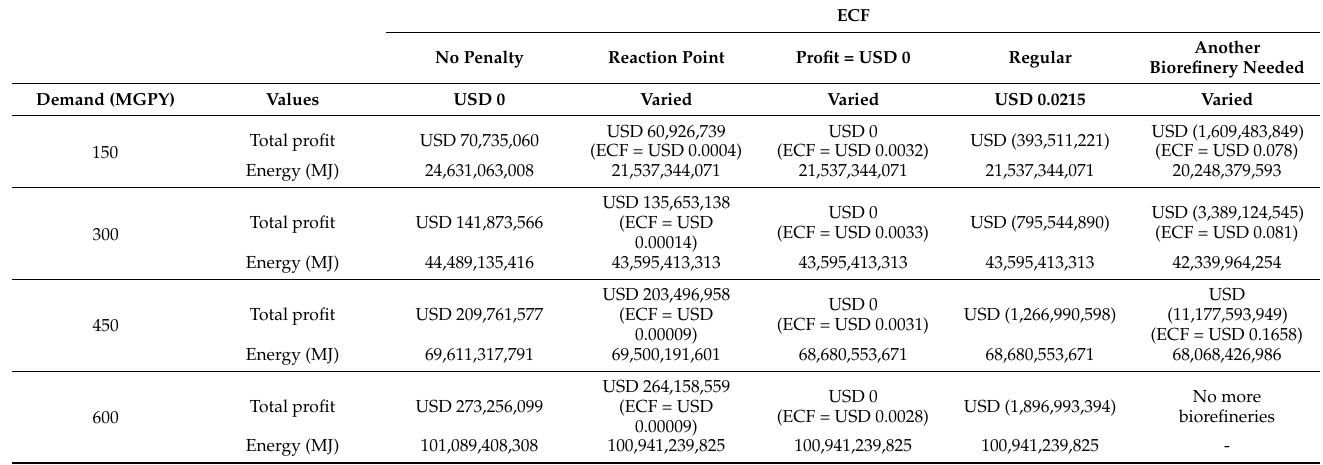
Table 7. Energy consumption and profit with different demand levels under different ECFs.